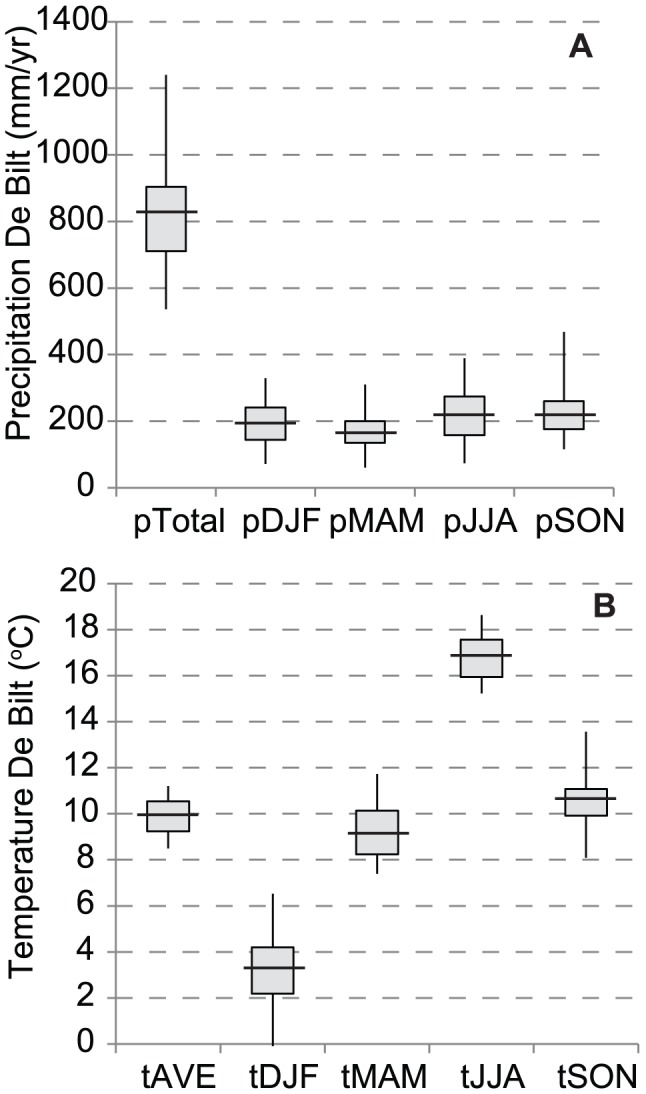
Annual and seasonal variability of the meteorological data from De Bilt.Values are expressed as the upper and lower quartiles, median, and minimum and maximum values of (a) cumulative precipitation and (b) mean temperature for AD 1969–2012.